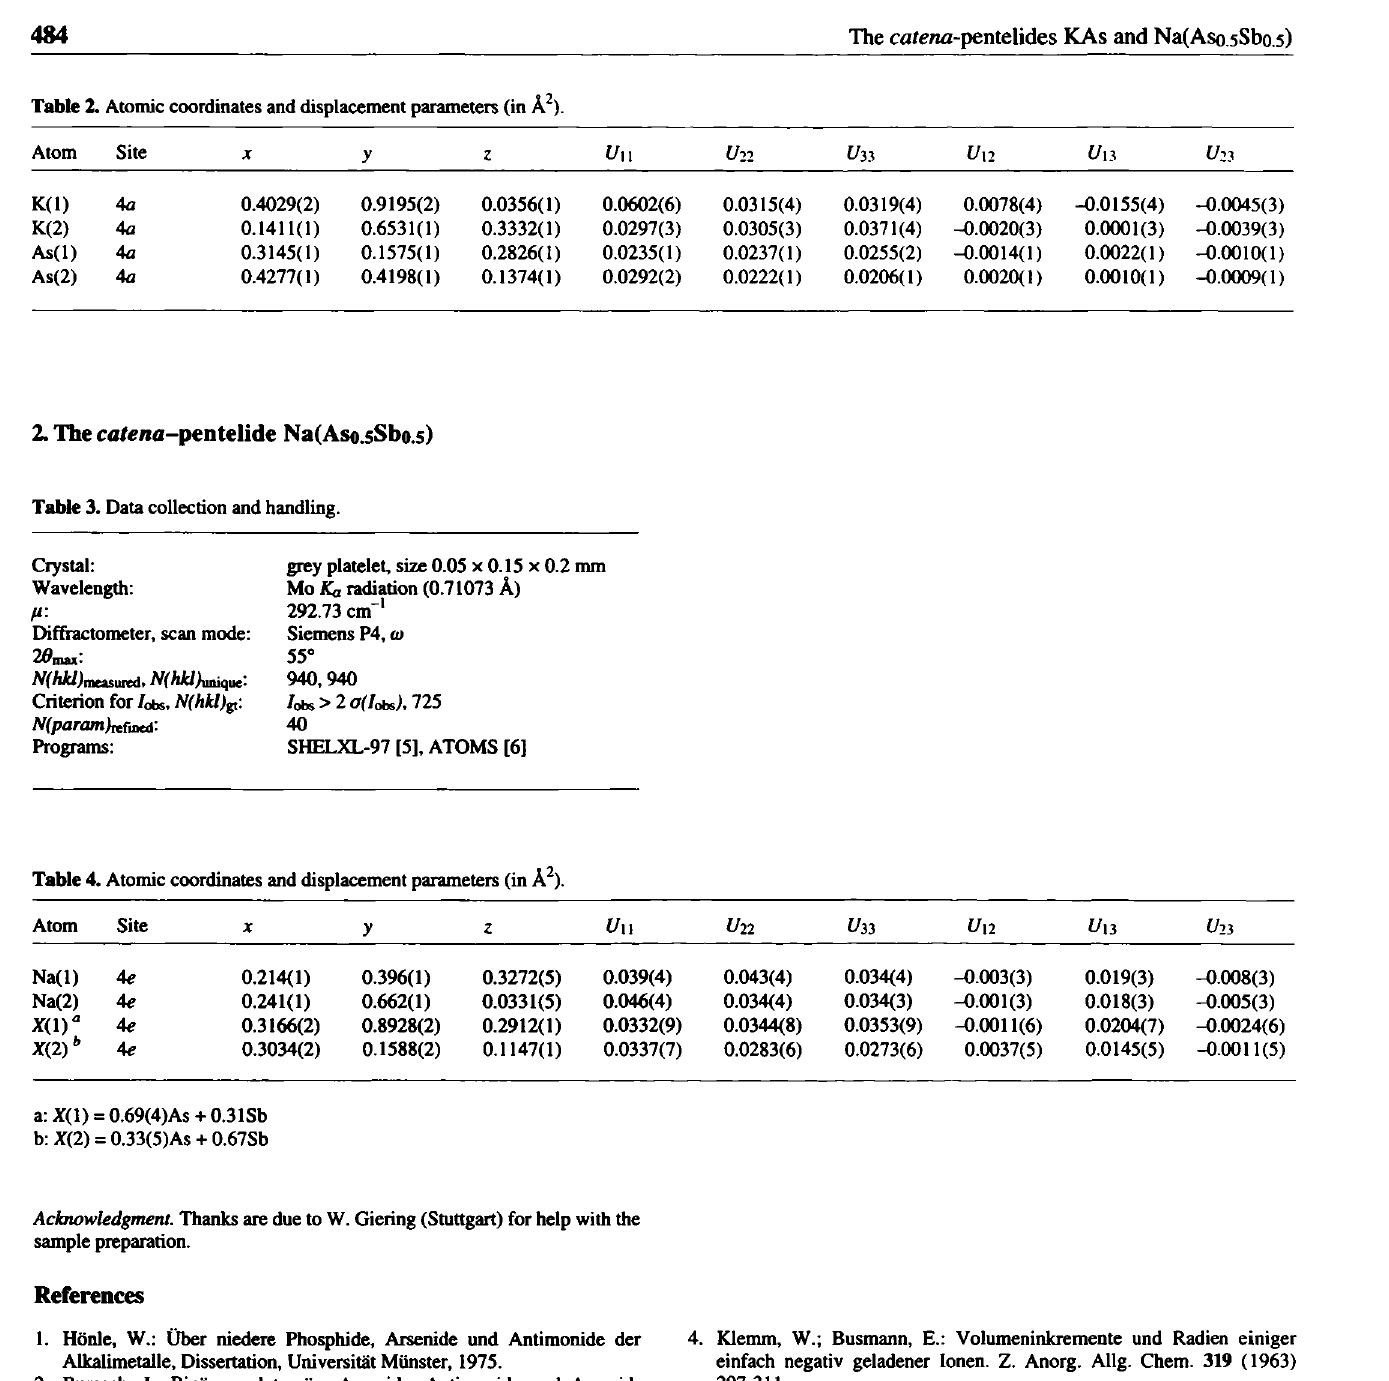
Table 4. Atomic coordinates and displacement parameters (in Â 2